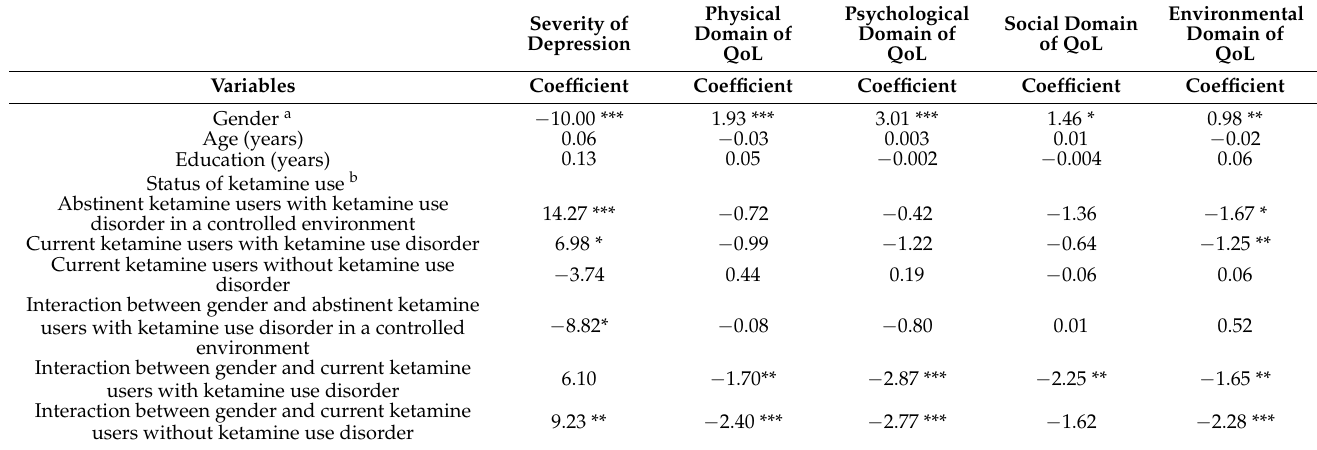
Table 4. Interactions between gender and the status of ketamine use with the severity of depression and quality of life